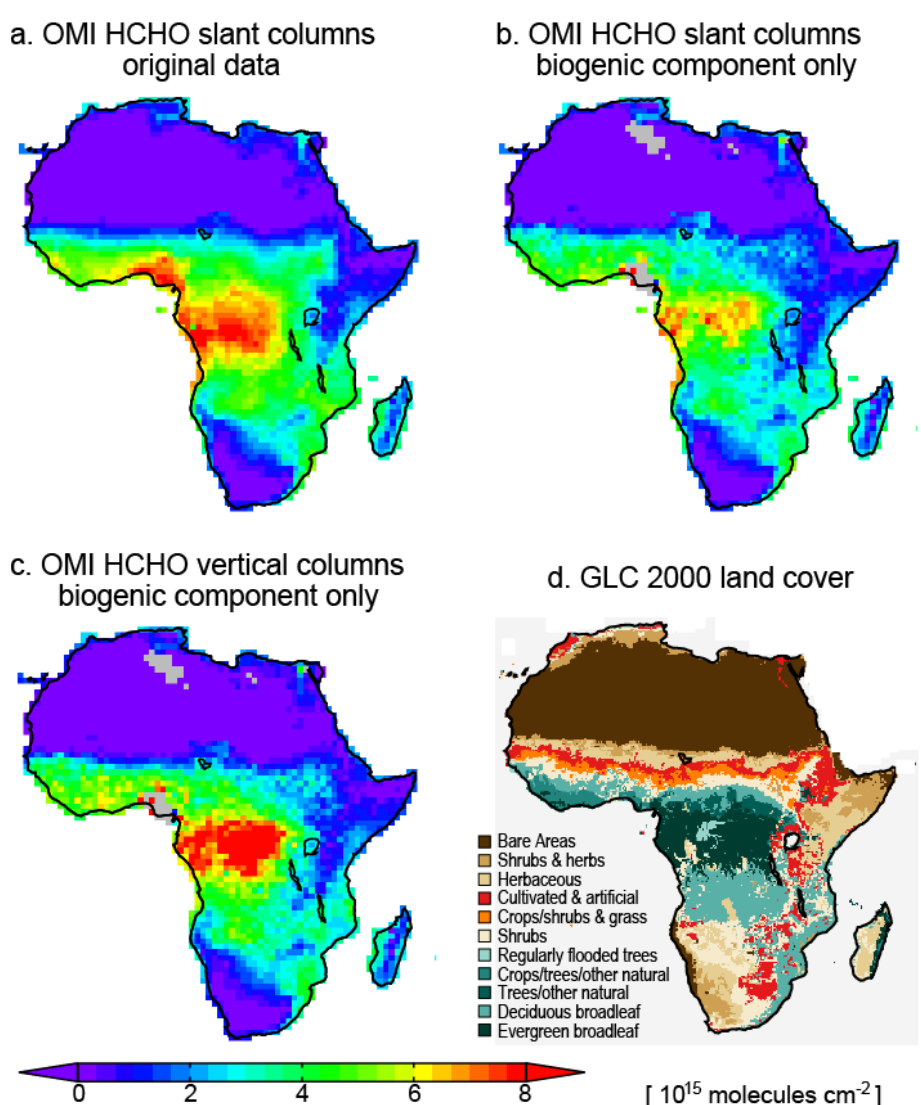
Fig. 1. HCHO columns and land cover types over Africa. The first three panels are annual mean HCHO columns for 2005–2009 at 1 × 1 ◦ resolution: (a) original slant columns, (b) biogenic slant columns after removing biomass burning, dust, and anthropogenic influences, (c) vertical columns obtained by applying air mass factors (AMFs) to the slant columns. The bottom right panel (d) shows the Global Land Cover (GLC) map for 2000 (Bartholom´e and Belward,